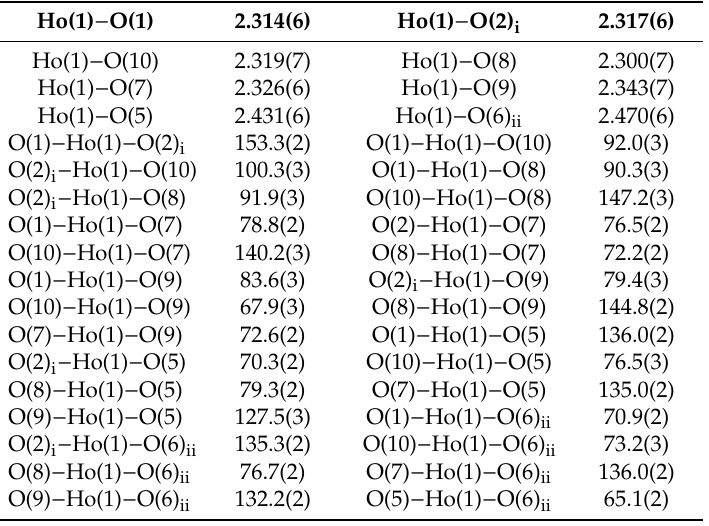
Table 2. Bond lengths (Å) and angles ( ◦ ) around Ho(III) ion in 1 1 .